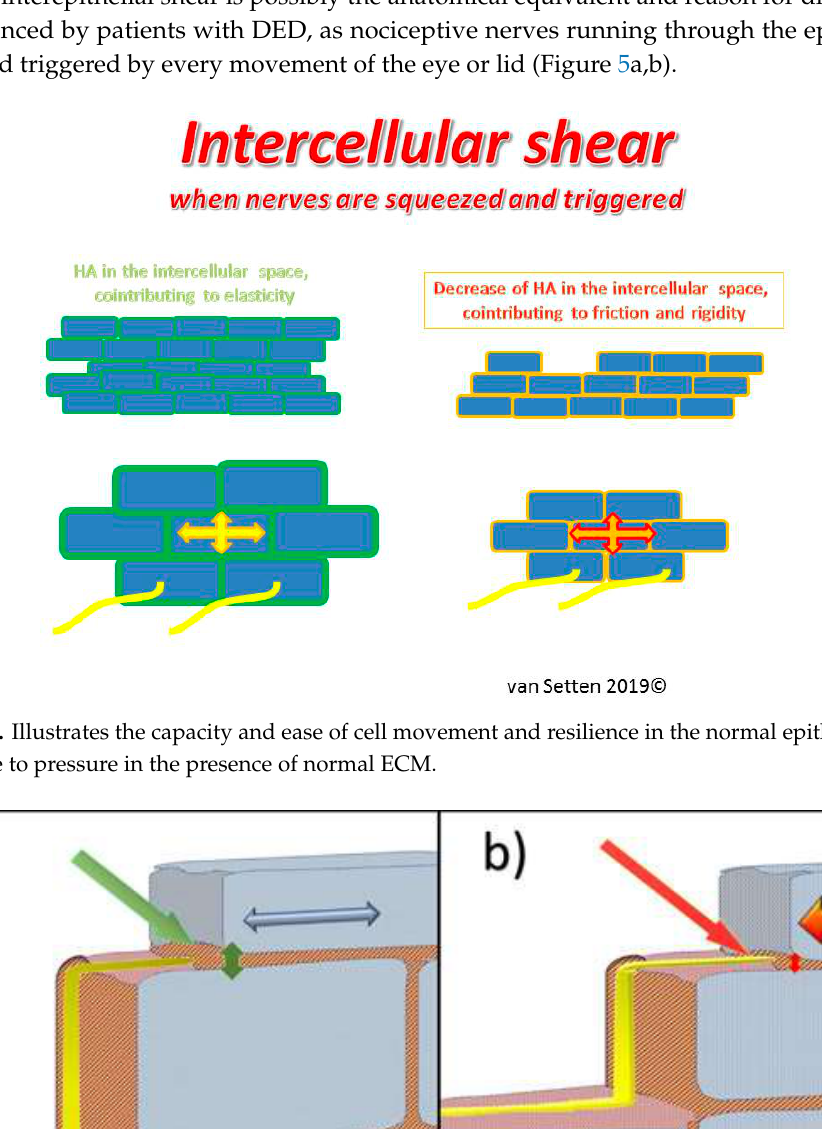
Figure 3. Histology picture identifying HA and CD 44 in human corneal epithelium. The schematic drawing illustrates the localization of HA (stained in red) within the cells and in the ECM even in the wing-cell layer, whereas CD44 (stained in white) is more concentrated in the basal cell layer.